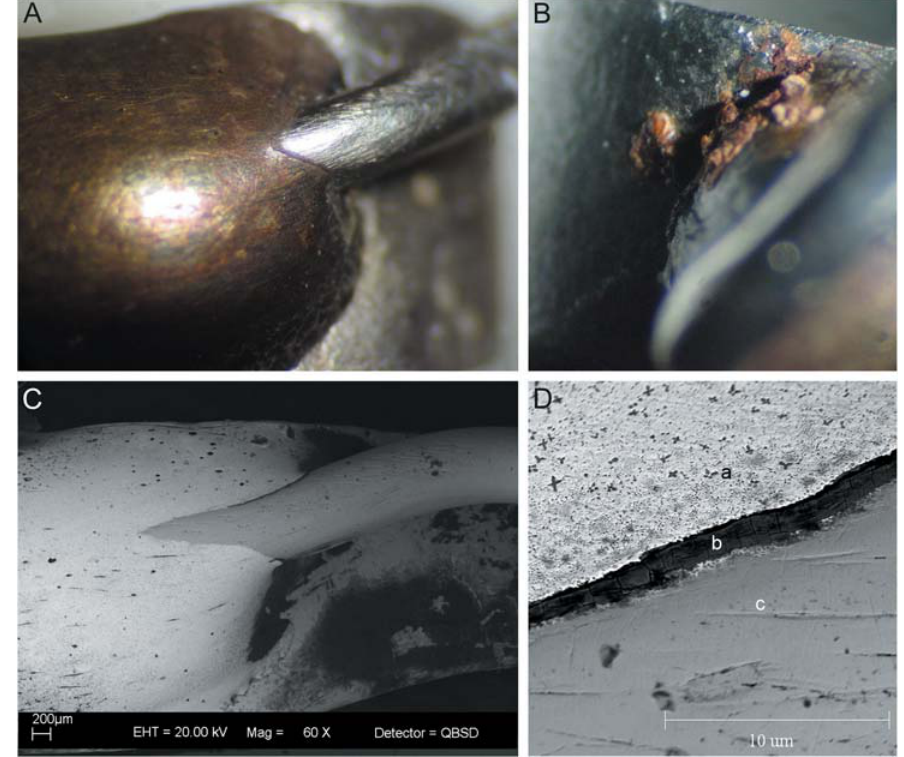
Figure 1- A: Stereomicroscopic analysis of a representative Group I specimen showing color change in the band/silver (cid:2)(cid:3)(cid:4)(cid:5)(cid:6)(cid:7)(cid:8)(cid:9)(cid:10)(cid:6)(cid:3)(cid:11)(cid:12)(cid:13)(cid:14)(cid:6)(cid:7)(cid:15)(cid:16)(cid:12)(cid:17)(cid:18)(cid:19)(cid:12)(cid:20)(cid:4)(cid:8)(cid:7)(cid:6)(cid:21)(cid:22)(cid:4)(cid:15)(cid:6)(cid:14)(cid:7)(cid:16)(cid:12)(cid:23)(cid:24)(cid:12)(cid:25)(cid:26)(cid:14)(cid:27)(cid:11)(cid:28)(cid:29)(cid:30)(cid:12)(cid:31)(cid:6)(cid:11)(cid:10)(cid:12)(cid:14)!(cid:12)"(cid:12)(cid:27)#(cid:14)(cid:10)(cid:6)(cid:7)(cid:8)(cid:12)(cid:22)(cid:14)(cid:26)(cid:14)(cid:3)(cid:12)(cid:22)#(cid:4)(cid:7)(cid:8)(cid:11)(cid:12)(cid:27)(cid:29)(cid:8)(cid:8)(cid:11)(cid:27)(cid:15)(cid:6)(cid:31)(cid:11)(cid:12)(cid:14)!(cid:12)(cid:22)(cid:14)(cid:3)(cid:3)(cid:14)(cid:27)(cid:6)(cid:14)(cid:7)(cid:12)(cid:4)(cid:15)(cid:12)(cid:15)#(cid:11)(cid:12)(cid:2)(cid:4)(cid:7)$(cid:9) (cid:27)(cid:6)(cid:26)(cid:31)(cid:11)(cid:3)(cid:12)(cid:2)(cid:3)(cid:4)(cid:5)(cid:6)(cid:7)(cid:8)(cid:9)(cid:10)(cid:6)(cid:3)(cid:11)(cid:12)(cid:13)(cid:14)(cid:6)(cid:7)(cid:15)(cid:16)(cid:12)(cid:17)%(cid:19)(cid:12)(cid:20)(cid:4)(cid:8)(cid:7)(cid:6)(cid:21)(cid:22)(cid:4)(cid:15)(cid:6)(cid:14)(cid:7)(cid:16)(cid:12)(cid:25)(cid:24)(cid:12)&(cid:22)(cid:4)(cid:7)(cid:7)(cid:6)(cid:7)(cid:8)(cid:12)(cid:11)(cid:26)(cid:11)(cid:22)(cid:15)(cid:3)(cid:14)(cid:7)(cid:12)(cid:20)(cid:6)(cid:22)(cid:3)(cid:14)(cid:27)(cid:22)(cid:14)(cid:30)’(cid:12)(&)*8(cid:12)(cid:20)(cid:6)(cid:22)(cid:3)(cid:14)(cid:8)(cid:3)(cid:4)(cid:30)#(cid:12)(cid:27)#(cid:14)(cid:10)(cid:6)(cid:7)(cid:8)(cid:12)(cid:15)#(cid:11)(cid:12)(cid:2)(cid:4)(cid:7)$(cid:9)(cid:27)(cid:6)(cid:26)(cid:31)(cid:11)(cid:3)(cid:12) (cid:2)(cid:3)(cid:4)(cid:5)(cid:6)(cid:7)(cid:8)(cid:9)(cid:10)(cid:6)(cid:3)(cid:11)(cid:12)(cid:13)(cid:14)(cid:6)(cid:7)(cid:15)(cid:12)(cid:15)(cid:14)(cid:12)(cid:2)(cid:11)(cid:12)(cid:4)(cid:7)(cid:4)(cid:26)’(cid:5)(cid:11)$(cid:12)(cid:2)’(cid:12)(cid:11)(cid:7)(cid:11)(cid:3)(cid:8)’(cid:12)$(cid:6)(cid:27)(cid:30)(cid:11)(cid:3)(cid:27)(cid:6)(cid:31)(cid:11)(cid:12);(cid:28)(cid:3)(cid:4)’(cid:12)(cid:27)(cid:30)(cid:11)(cid:22)(cid:15)(cid:3)(cid:14)(cid:27)(cid:22)(cid:14)(cid:30)’(cid:12)()<&8(cid:16)(cid:12)(cid:17)=(cid:19)(cid:12)(cid:20)(cid:4)(cid:8)(cid:7)(cid:6)(cid:21)(cid:22)(cid:4)(cid:15)(cid:6)(cid:14)(cid:7)(cid:16)(cid:12)<(cid:24)(cid:12)"(cid:3)(cid:11)(cid:4)(cid:27)(cid:12)(cid:14)!(cid:12)"(cid:8)(cid:12)(cid:27)(cid:14)(cid:26)$(cid:11)(cid:3)(cid:12) (a), material-to-material interface (b) and orthodontic wire (c) analyzed by EDS with four-quadrant electron backscatter